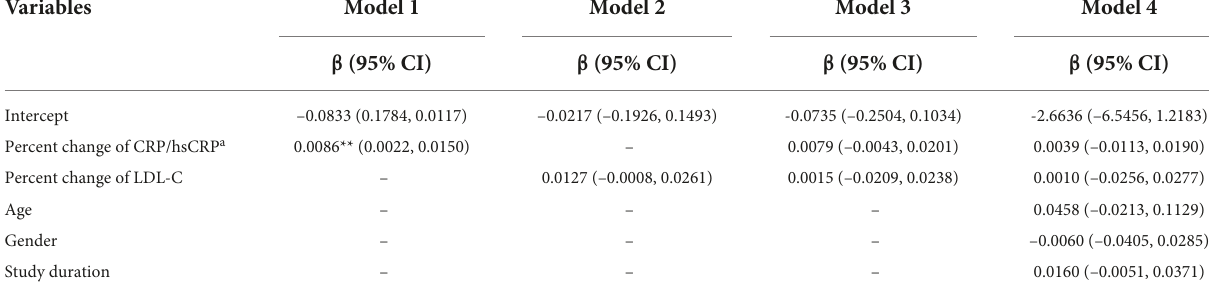
TABLE 3 Meta-regression analysis for SMD in change of